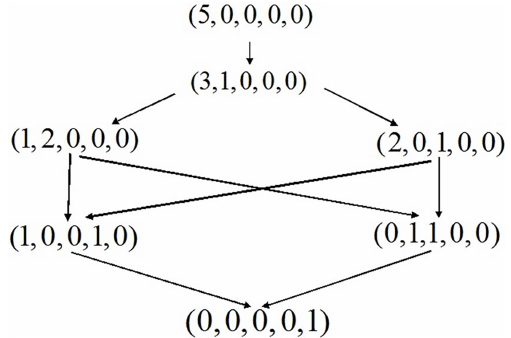
Figure 1. State space obtained from the initial condition P( 5 , 0 , 0 , 0 , 0 ; 0 ) = 1 with the constraint